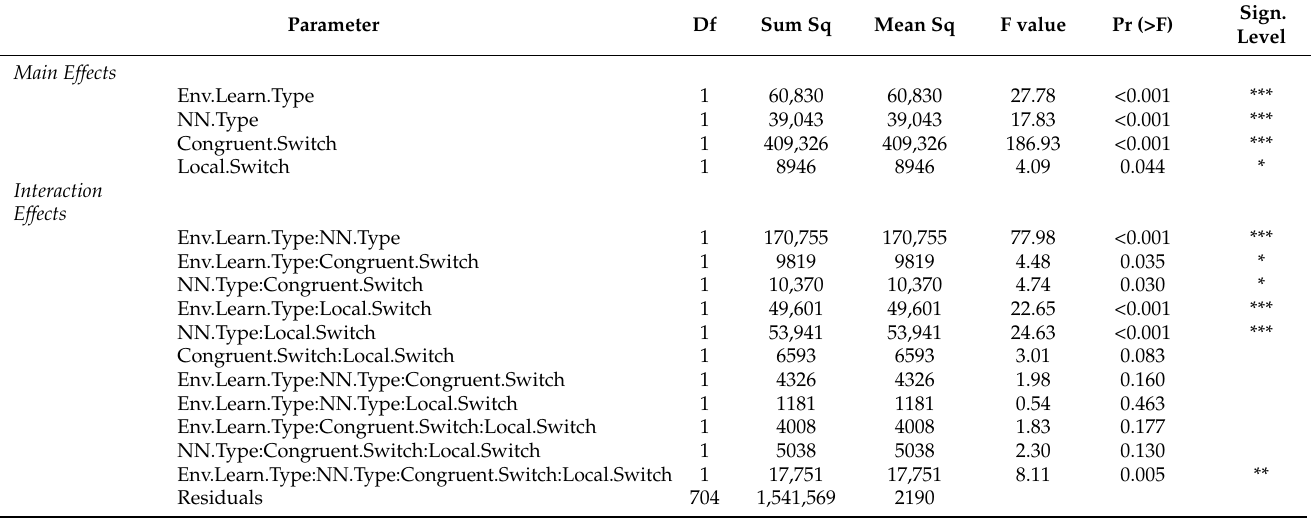
Table 5. Parameter Effects ANOVA—Deconverge Cnt. Asterisks denote significance level (*** <0.001, ** <0.01, *